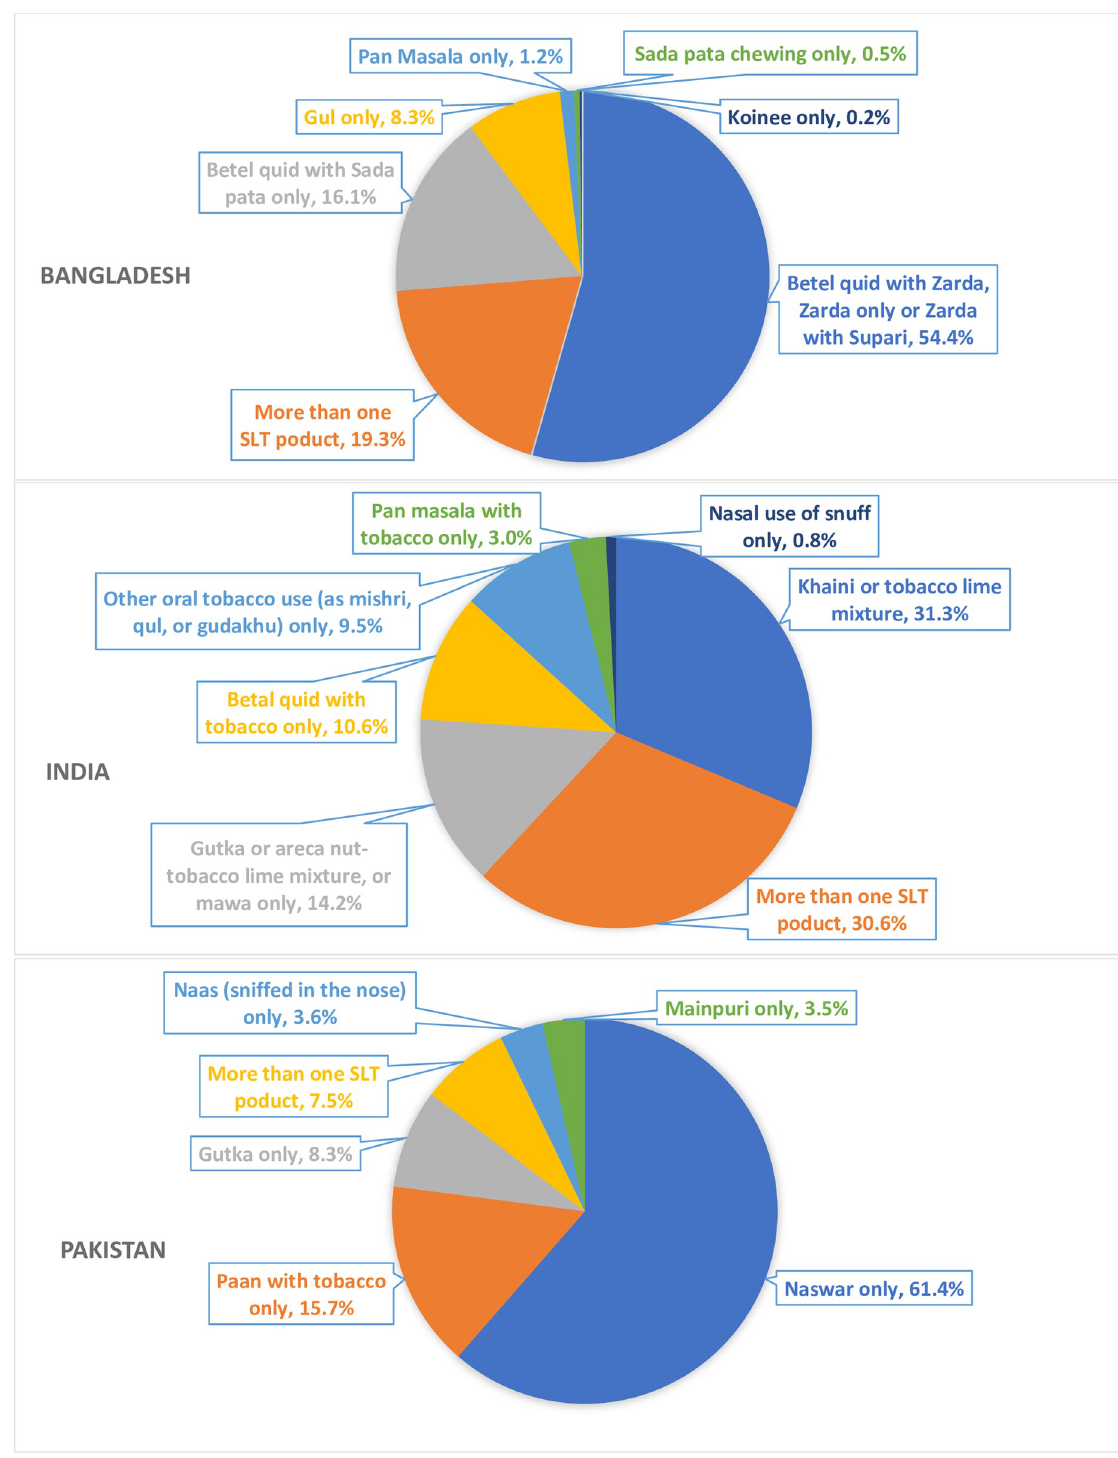
Fig 1. Distribution of various smokeless tobacco products among current smokeless tobacco user in Bangladesh, India and Pakistan, GAT 2014–2017.